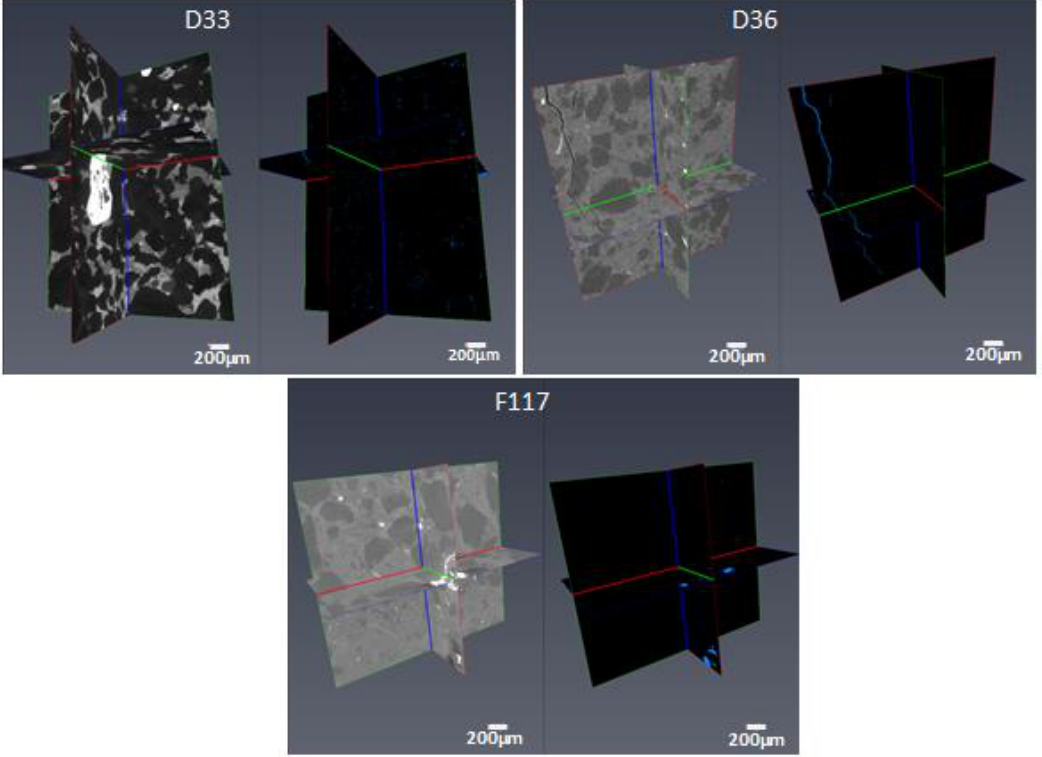
Figure 19. High-resolution µ CT images and their segmentations for samples in group 1 ( < 7% porosity). CT images taken at 3- µ m resolution.